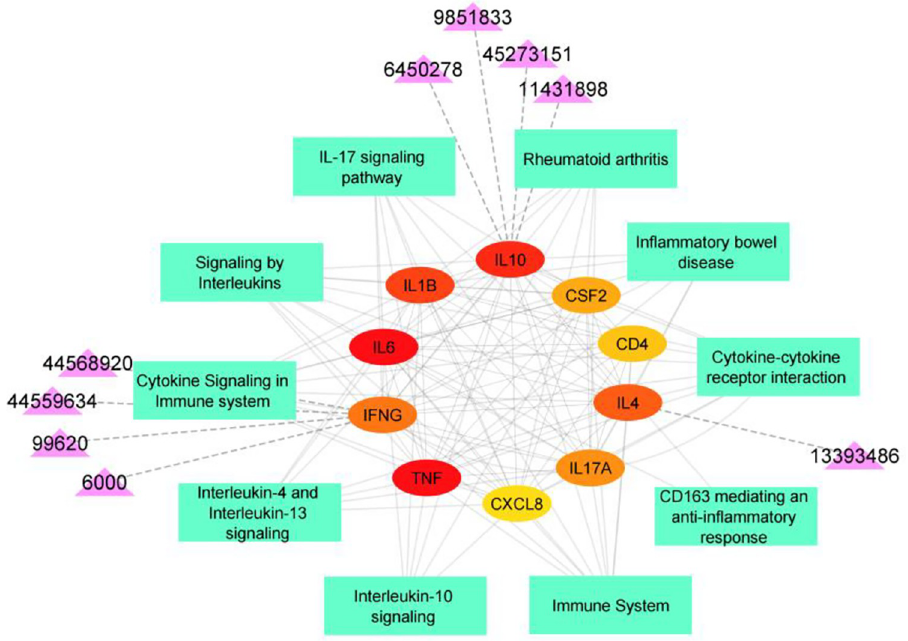
Fig 8. Compound-target-pathway network constructed in cytoscape. * Ellipse-shaped nodes represent ten hub genes. Rectangle-shaped nodes represent the pathways involved by the genes. Triangle-shaped nodes represent the top nine compounds, and the dotted line represents the interaction between the nine compounds with the genes IFNG, IL10 and IL4.